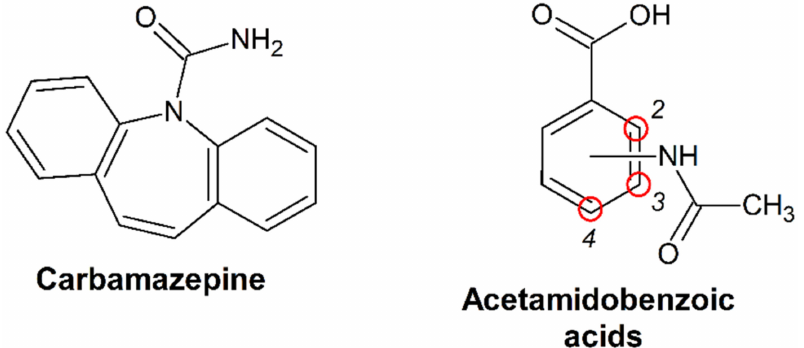
Figure 1. Molecular structures of carbamazepine and isomers of acetamidobenzoic acid studied in this